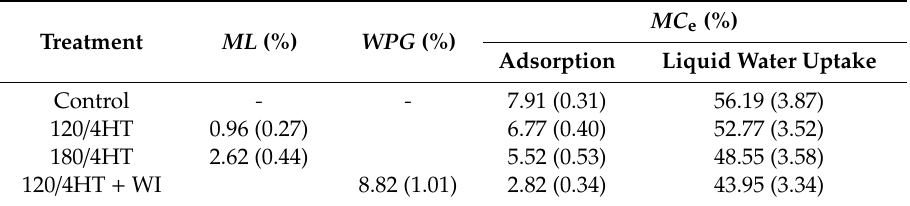
Table 2. Experimental design for HT and WI